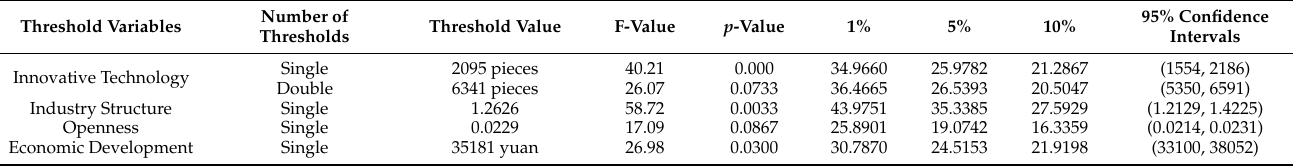
Table 6. Threshold estimates and tests of the threshold